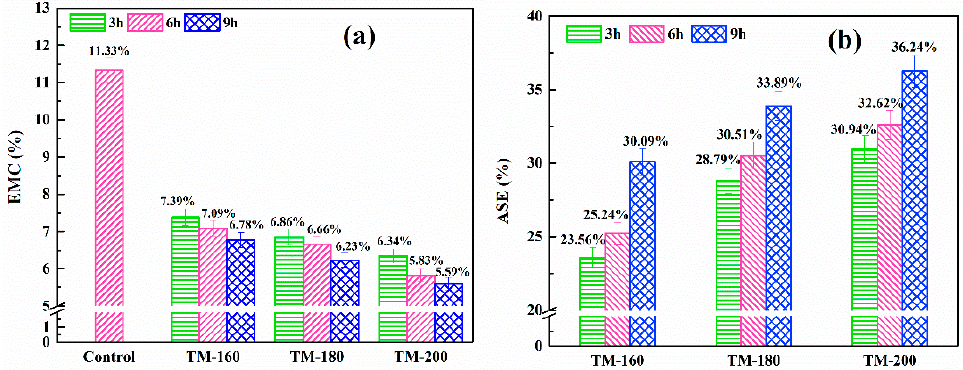
Figure 6. Effect of thermal modification on the EMC ( a ) and ASE ( b ).